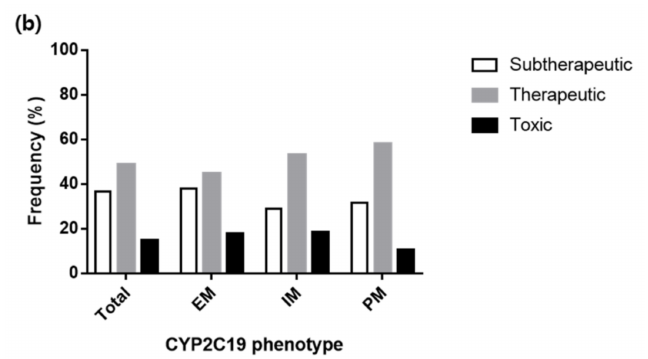
Figure 4. Probability of voriconazole therapeutic target attainment from model-based simulations of voriconazole pharmacokinetic profiles after the following voriconazole oral dosing regimens on day 7; ( a ) standard dosing regimen (400 mg twice daily for two doses followed by 200 mg twice daily), ( b ) dosing according to CYP2C19 phenotype as follows: EM, 400 mg twice daily; IM, 400 mg twice daily for two doses followed by 200 mg twice daily; PM, 400 mg twice daily for two doses followed by 100 mg twice daily. Therapeutic target range for voriconazole trough plasma concentration was from 2.0 to 5.5